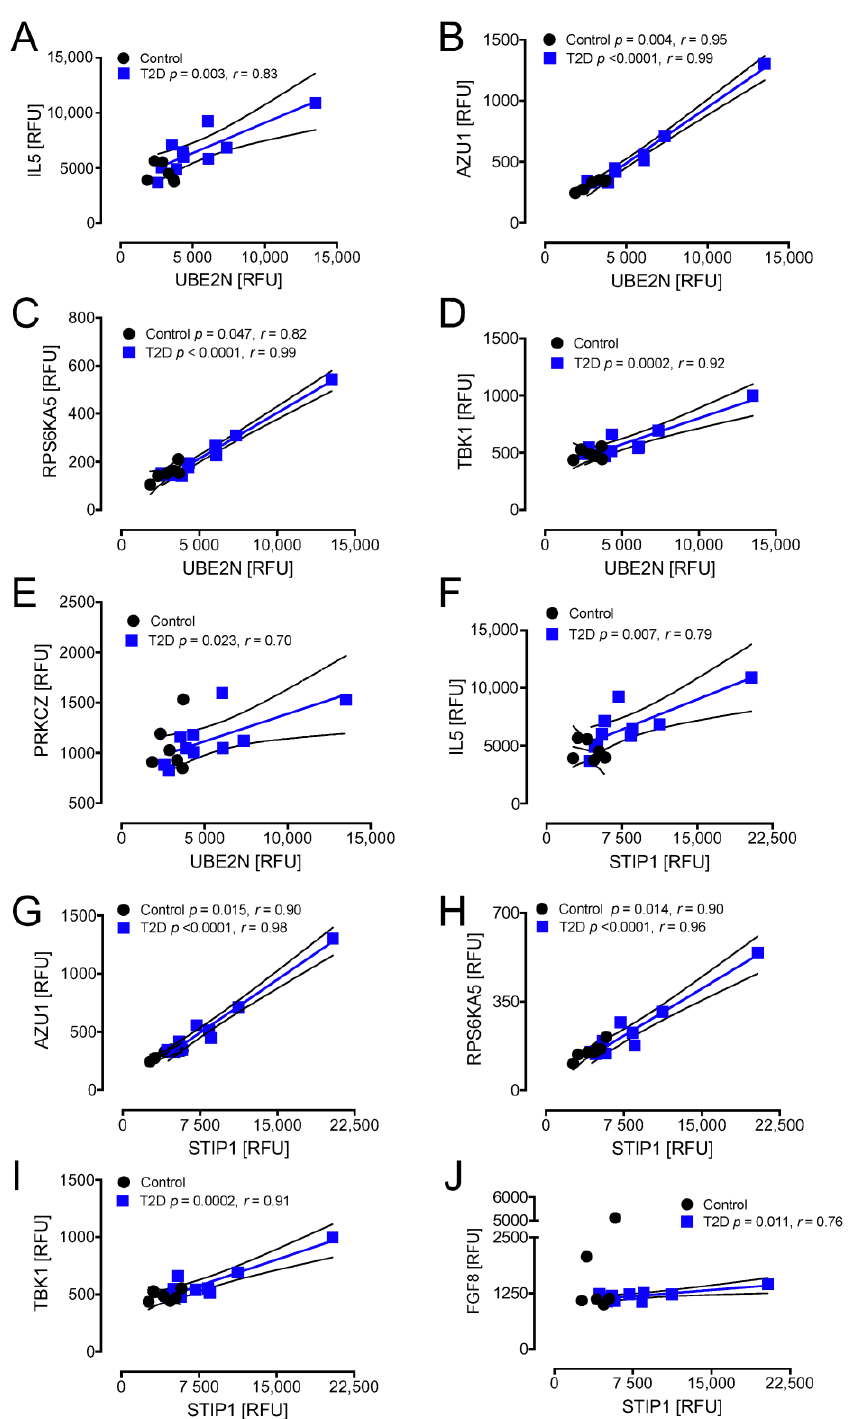
Figure 5. Correlations of HSPs that changed significantly from baseline to hypoglycemia in T2D with inflammatory markers at hypoglycemia. At hypoglycemia, UBE2N showed a positive correlation with IL5 ( A ), AZU1 ( B ), RPS6KA5 ( C ), TBK1 ( D ), and PRKCZ ( E ) in T2D subjects; UBE2N also had a positive correlation with RPS6KA5 ( C ) in control subjects. STIP 1 showed a positive correlation with IL5 ( F ), TBK1 ( I ), and FGF8 ( J ) in T2D subjects alone and with AZU1 ( G ) and RPS6KA5 ( H ) in both T2D and control subjects. UBE2N, ubiquitin-conjugating enzyme E2 N; STIP1, stress- induced-phosphoprotein 1; AZU1, azurocidin 1; RPS6KA5, ribosomal protein S6 kinase 5; TBK1, TANK-binding kinase 1; PRKCZ, protein kinase C zeta type; IL5, interleukin 5; FGF8, fibroblast growth factor 8; RFU, relative fluorescent